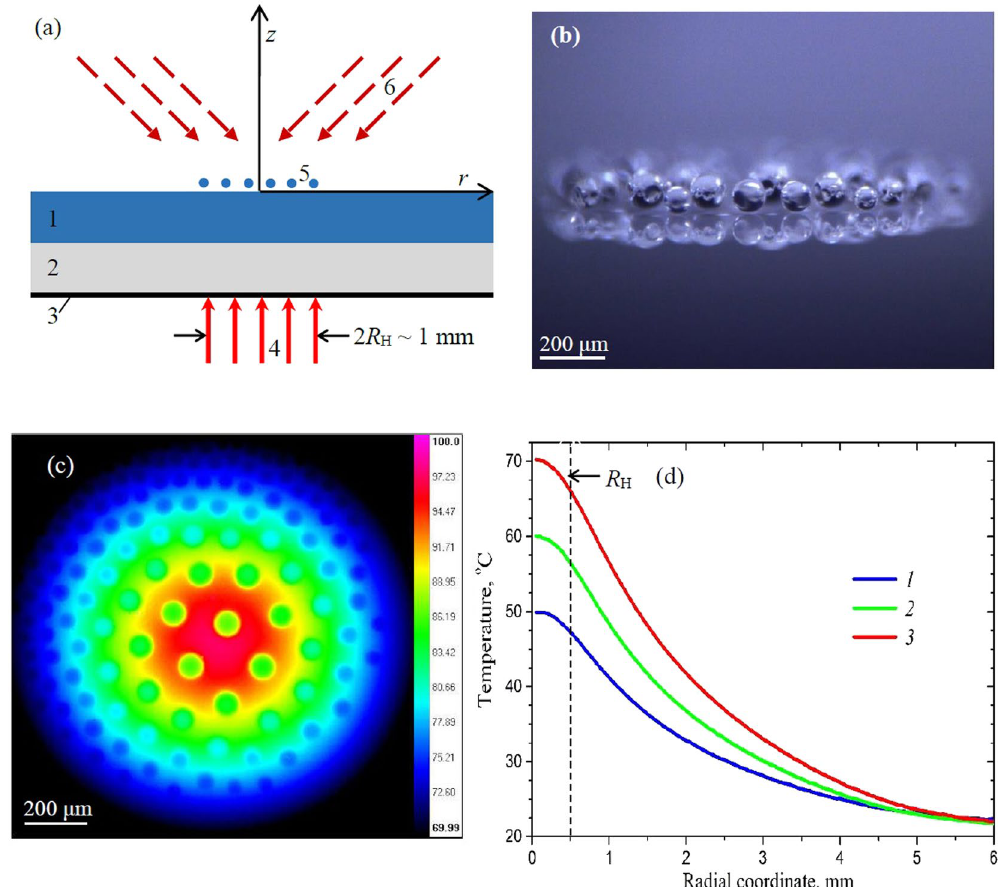
Figure 1. ( a ) The schematic of experimental setup: the water layer (1) on glass-ceramic substrate (2) with light-absorbing coating (3) is heated by laser beam (4) and generates droplet cluster (5) stabilized by infrared irradiation (6). ( b ) Side view of the cluster. ( c ) Top view, the infrared image and ( d ) radial temperature profiles of water surface under the cluster at the laser power of 208.6 mW (1), 297.1 mW (2), and 411.4 mW